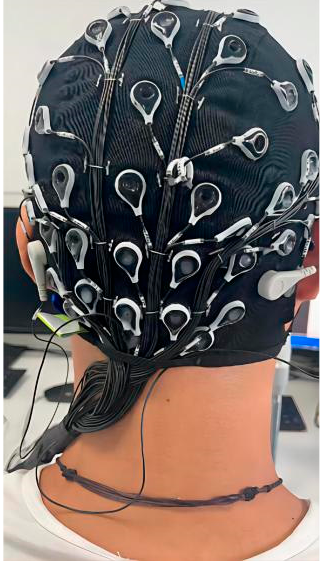
Figure 1. EEG cap containing cerebellar regions.